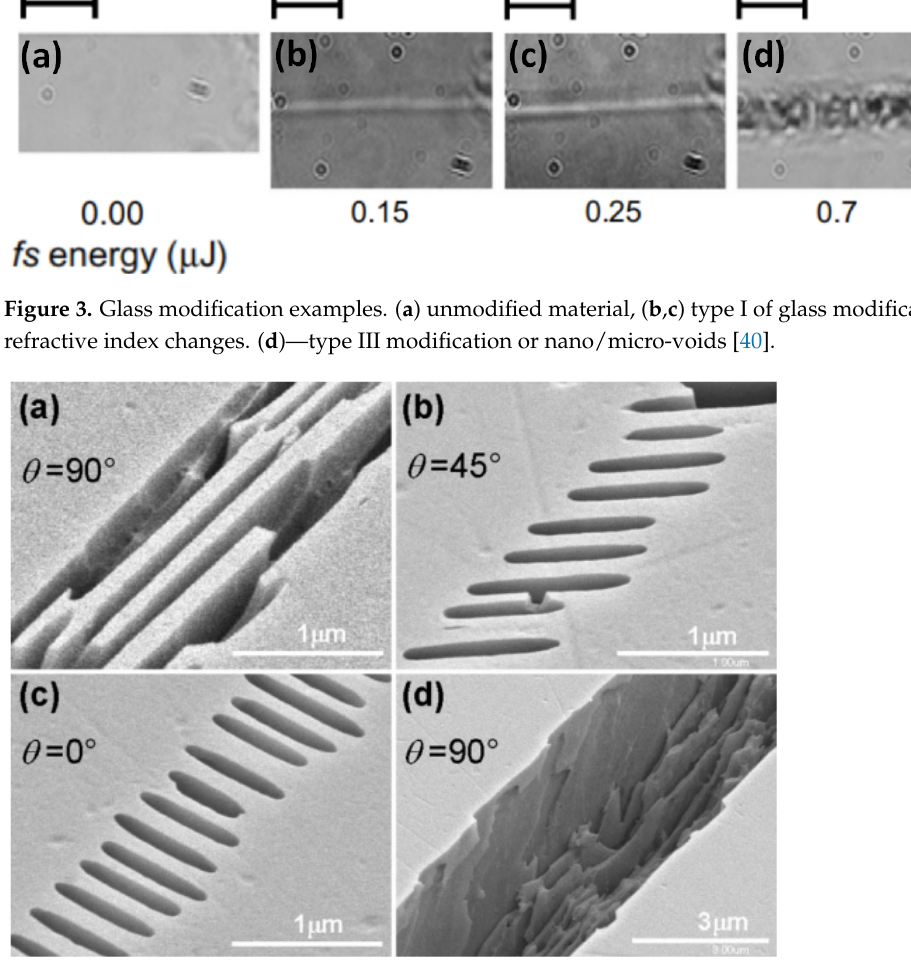
Figure 4. Examples of type II glass modification and visualization of nanogratings direction de- pendency to light polarization. ( a ) Nanogratings induced with light polarization perpendicular to scanning direction- the angle between polarization and scanning direction 90 ◦ , ( b ) 45 ◦ and ( c ) 0 ◦ . ( d ) Nanogratings modification after etching